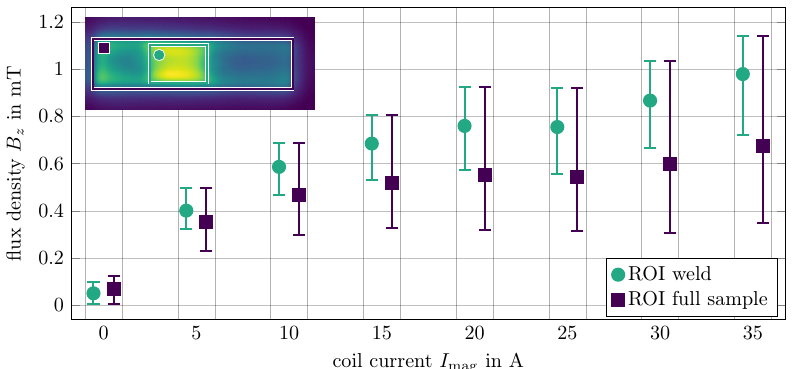
Figure 7. Measurement results of the residual magnetic flux density measurements of the cross- sectional sample with increasing coil current and presentation of the evaluation by means of ROI with the mean, minimum and maximum values therein.